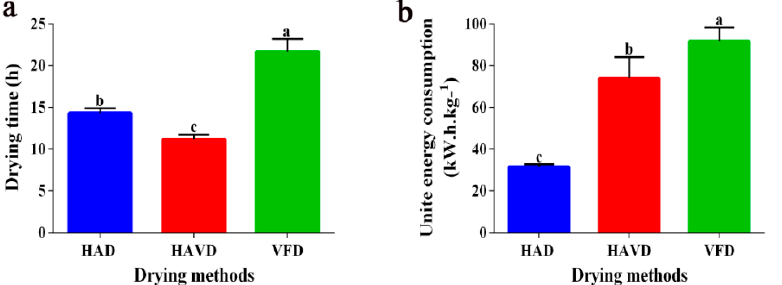
Figure 1. Drying time ( a ) and unit energy consumption ( b ) of L. decastes under different drying methods; HAD: hot-air-drying sample; HAVD: hot-air-combined-with-vacuum-drying sample; VFD: vacuum-freeze-drying sample. Different letters (a, b, c) indicate significant differences between treatments ( p < 0.05).